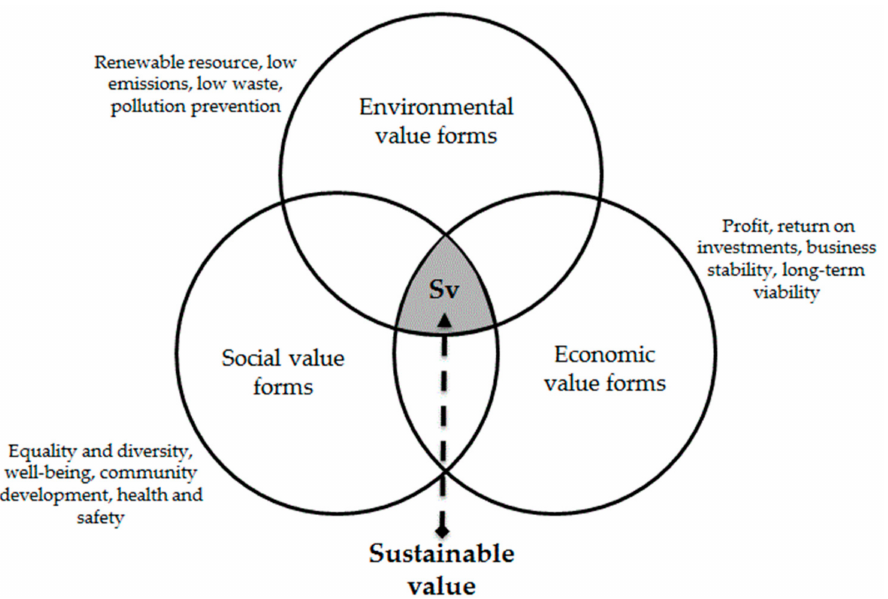
Figure 2. A holistic view of sustainable value integrating economic, environmental, and social value forms. Source: Own study based on